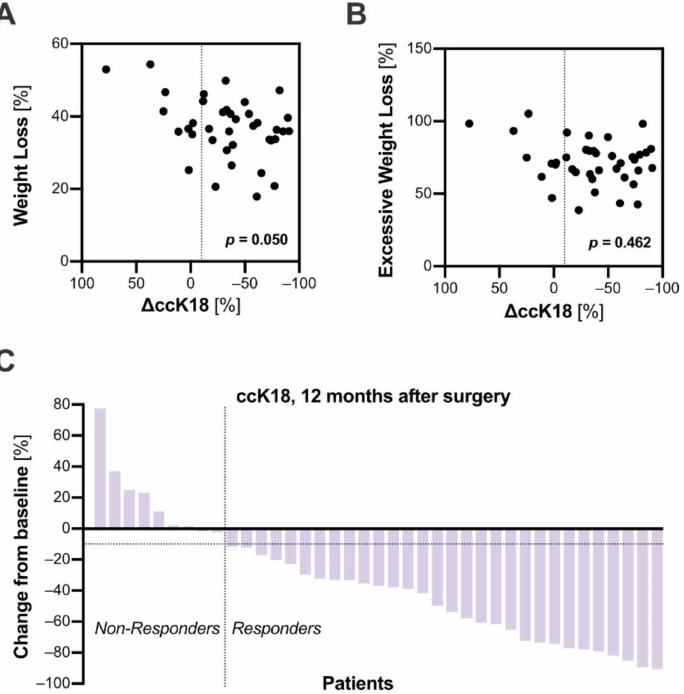
Figure 2. Consecutive ccK18 measurements identified non-responders to bariatric surgery. The individual changes in ccK18 levels during the one-year follow up ( ∆ ccK18) were neither associated with ( A ) total body weight loss (r = 0.32), nor with ( B ) excessive weight loss (r = 0.12). Excessive weight loss was calculated relative to a body mass index of 25. Spearman’s correlation coefficient was applied. Panel ( C ) shows a waterfall plot, depicting the individual change in ccK18 levels 12 months after surgery, compared to preoperative values, for each patient. While most patients experienced a decline, some presented unaltered or even increased ccK18 levels. For further analysis, we categorized patients into “Responders” and “Non-Responders”, defining response as a decline in ccK18 levels ≥ 10% one year